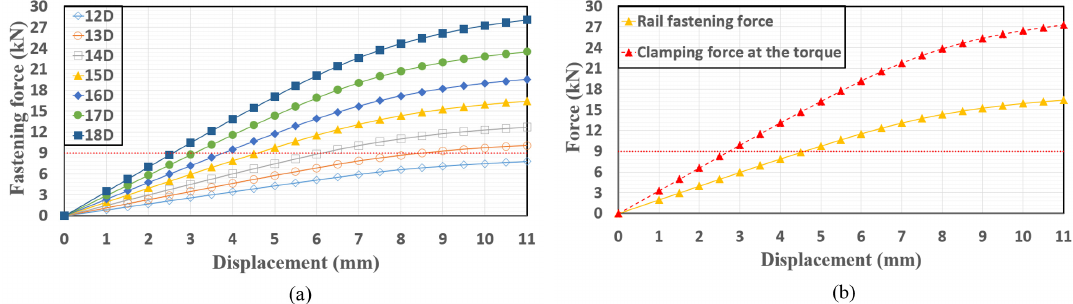
Figure 15. Force vs. displacement diagram: ( a ) fastening force vs. displacement when varying the spring diameter; ( b ) comparison of clamping force at the torque with rail fastening force (for the 15D model).